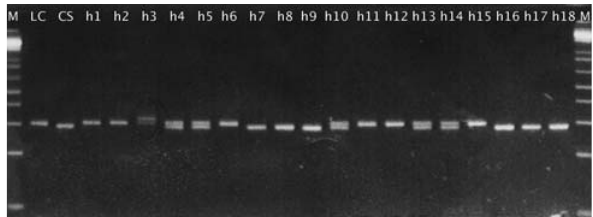
Figure 2 - Amplification for SSR derived from the CitEST database in Rangpur Lime (LC), Swingle Citrumelo (CS) and progeny (h1-h18). Mo- lecular marker of 100 bp (M).